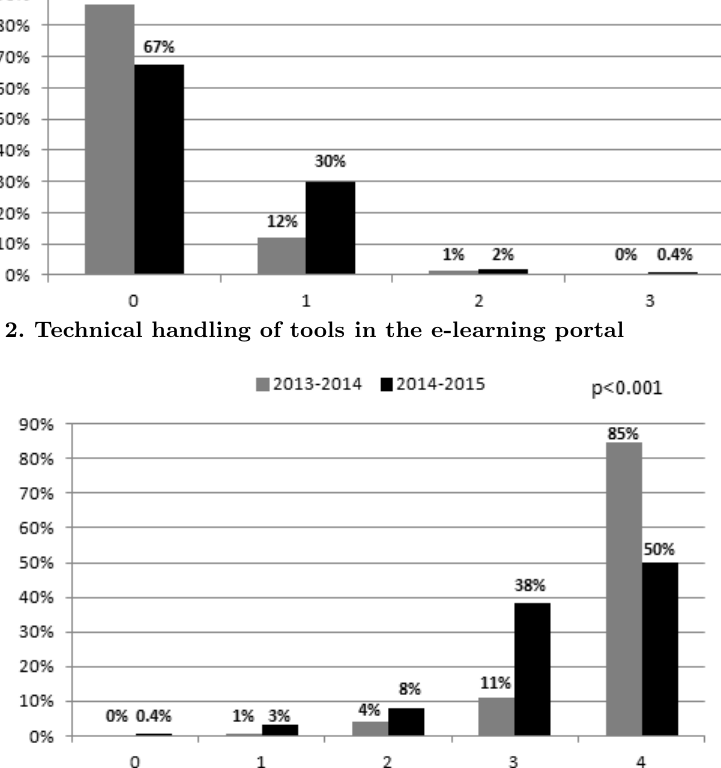
Figure 3. Distance courses in the future